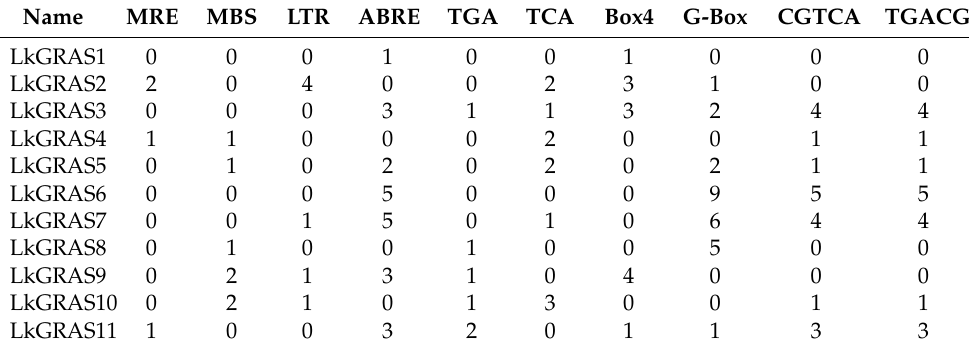
Table 2. Cis -element analysis of promoter regions of LkGRAS